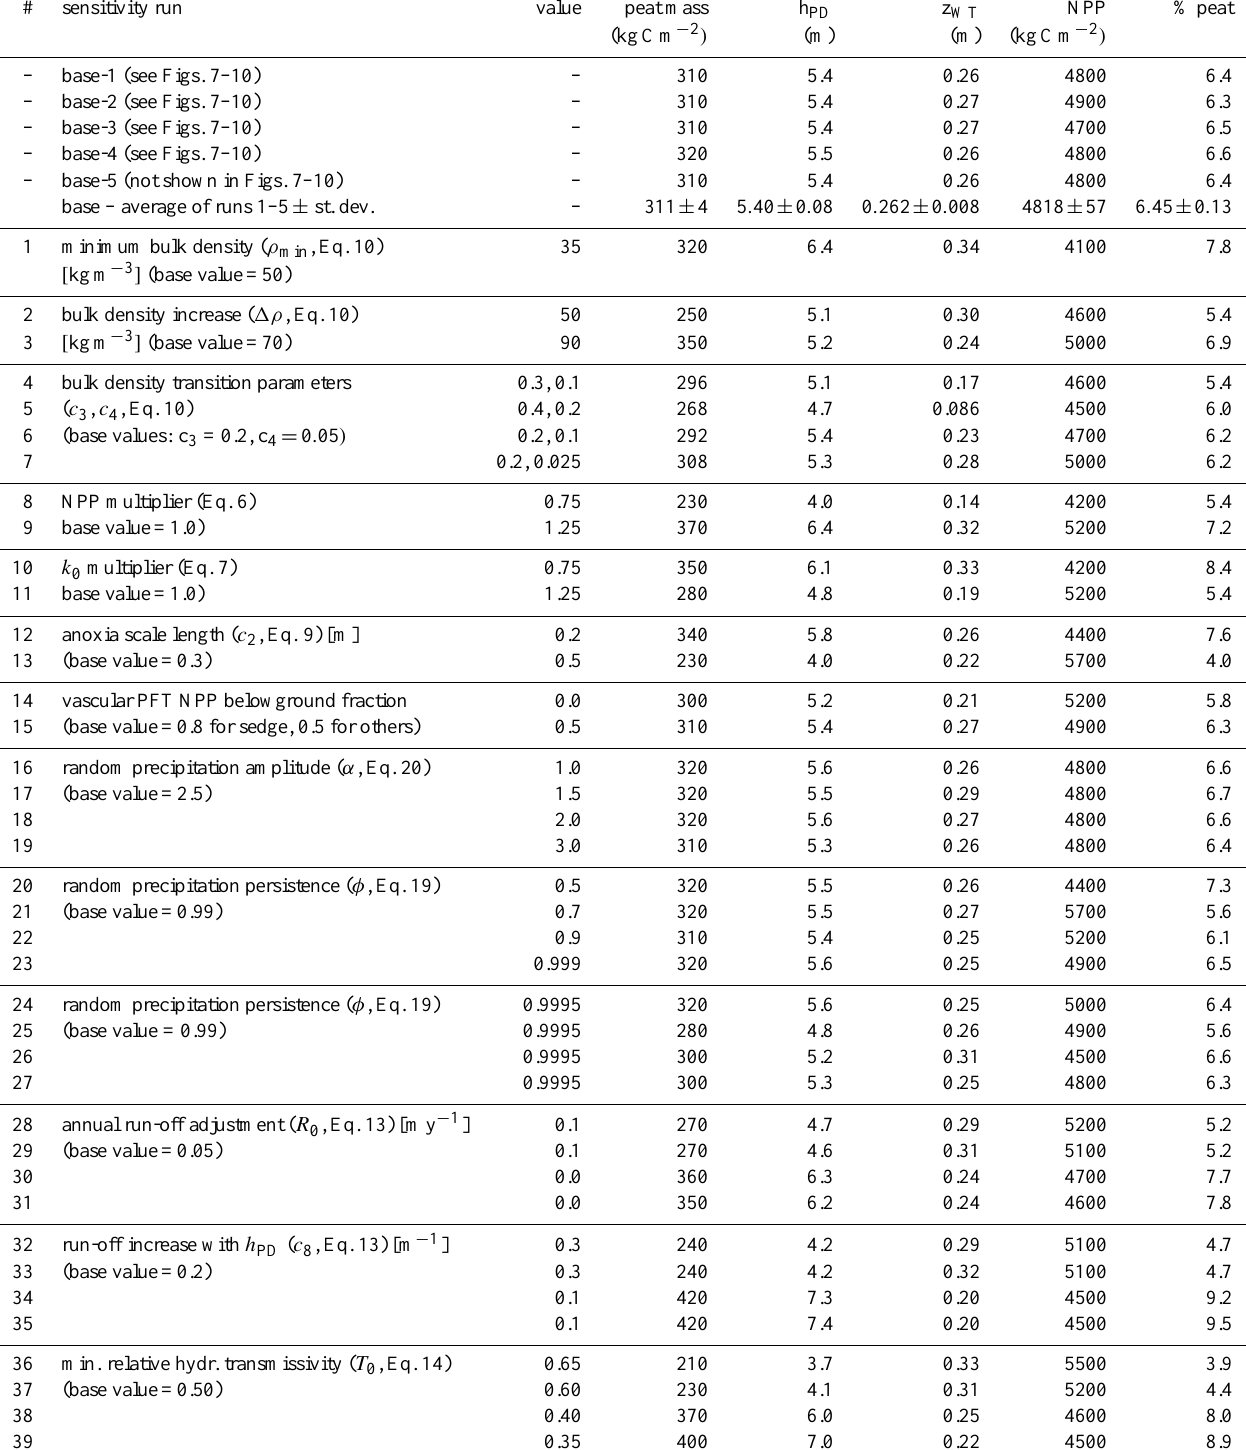
Table 5. Sensitivities in 8500-year HPM simulations of final peat mass, final peat depth ( h PD ) , and water table depth ( z WT – mean of last 40 years of 8500 year simulation), and total vegetation productivity (NPP), and percent NPP remaining as peat at end of simulation (% peat). Results reported to 2 significant figures, except